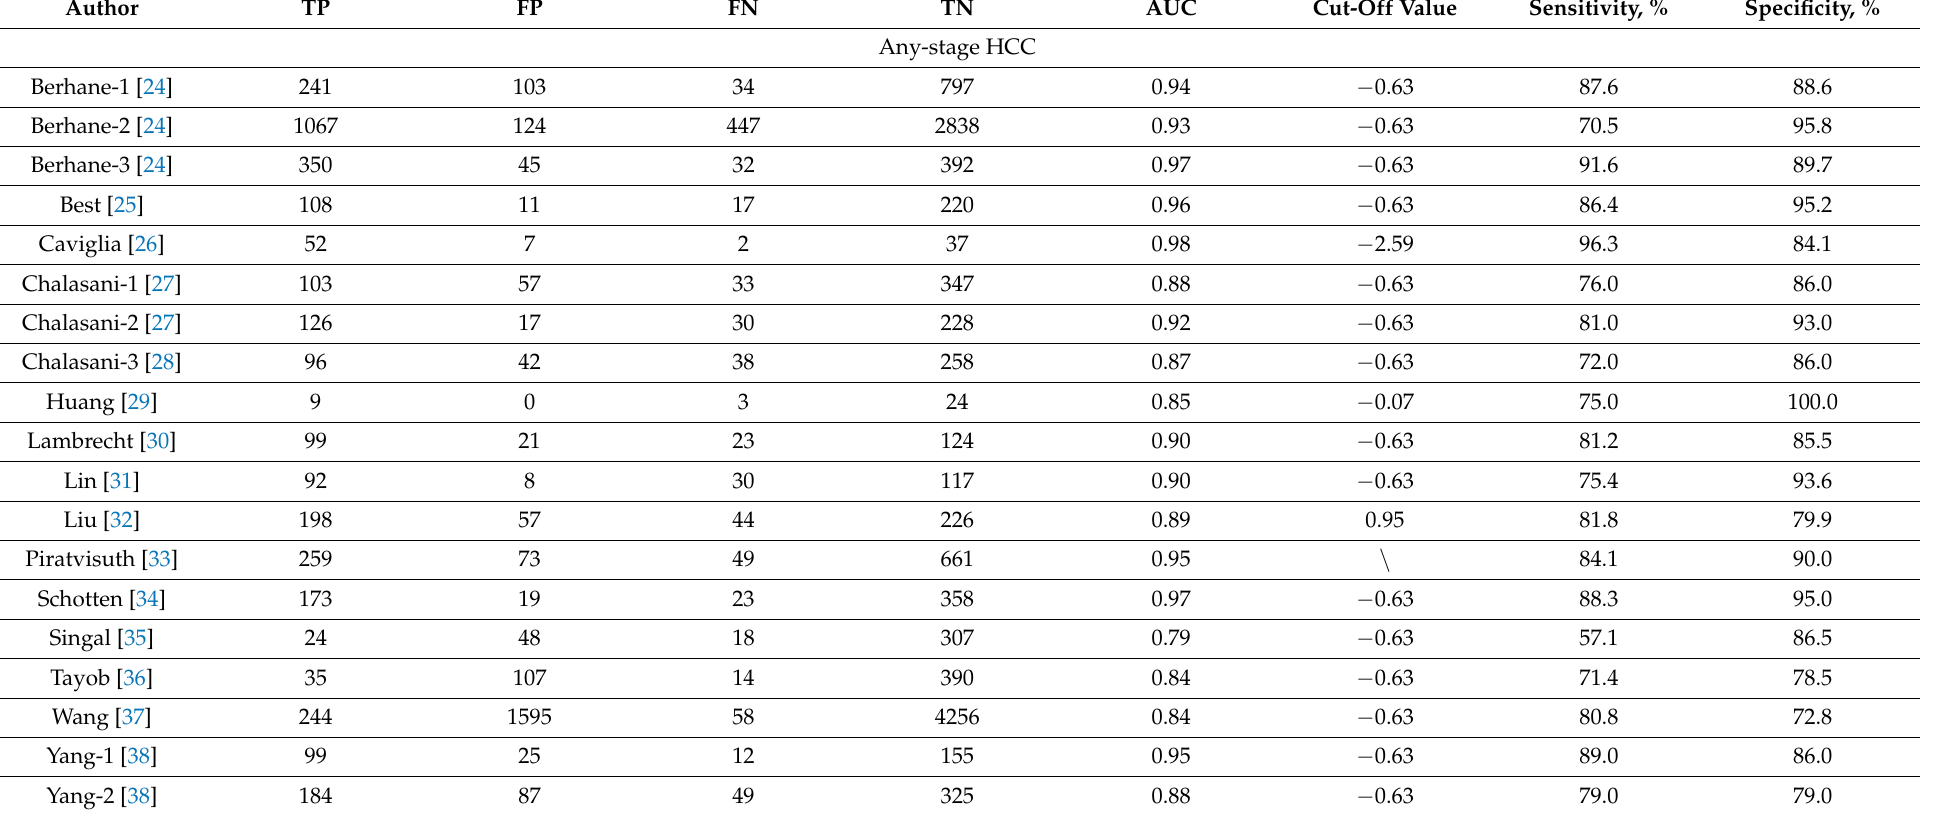
Table 2. Summary of the diagnostic performance of the GALAD score for detecting any-stage HCC or early-stage